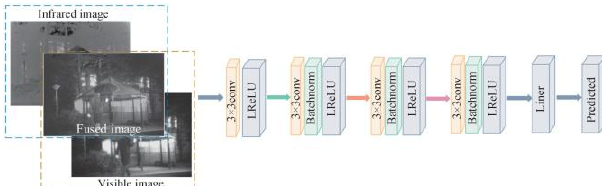
Figure 3. Network structure of the